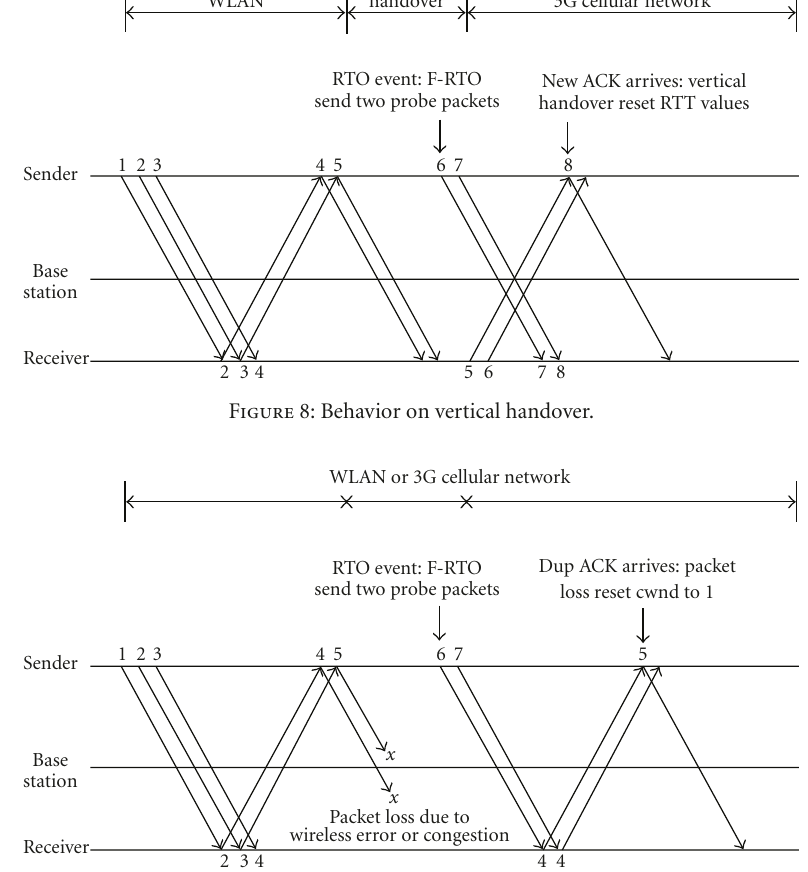
Figure 9: Behavior on normal